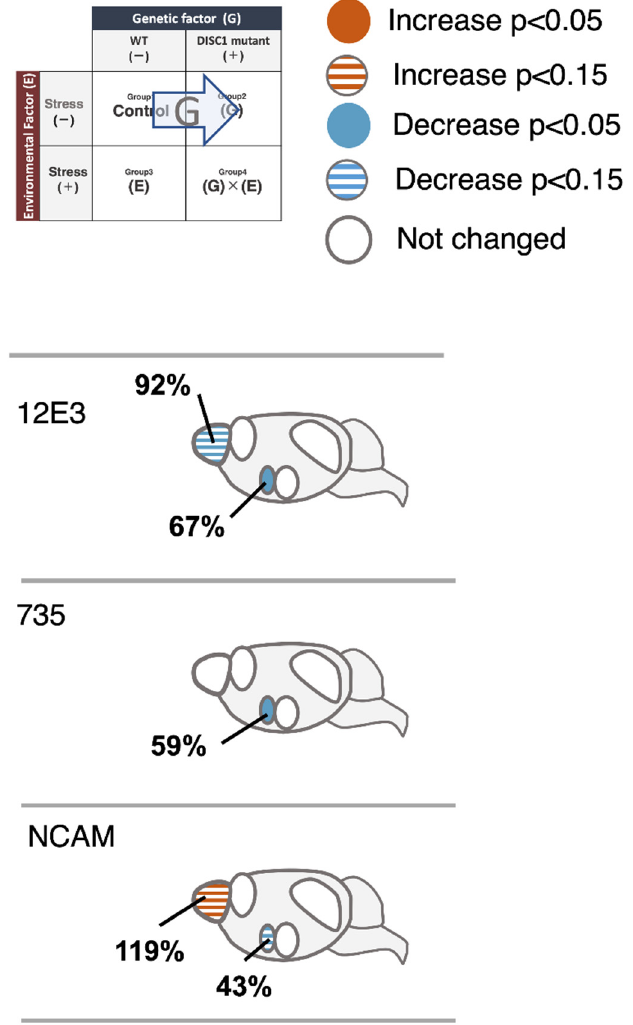
Figure 6. Effect of a genetic factor (DISC1 mutant) on the expression of polySia and NCAM. Heat map of changes observed using the 12E3, 735, and NCAM antibodies. [WT, TS − ] (group 1) was set to 100%.